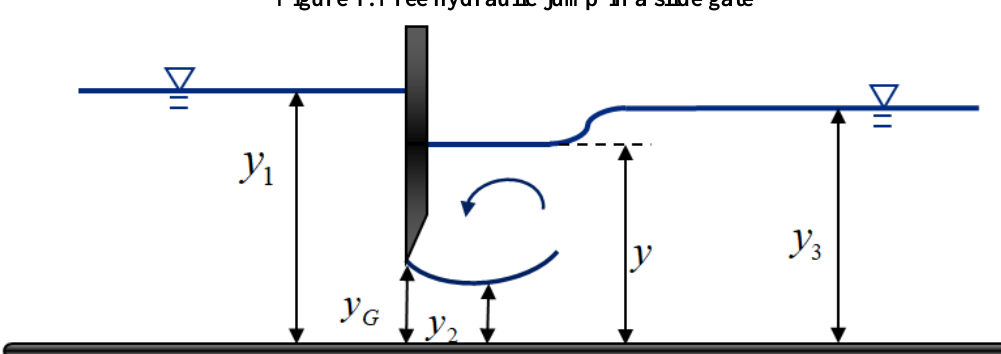
Figure 2. Submerged hydraulic jump in a slide